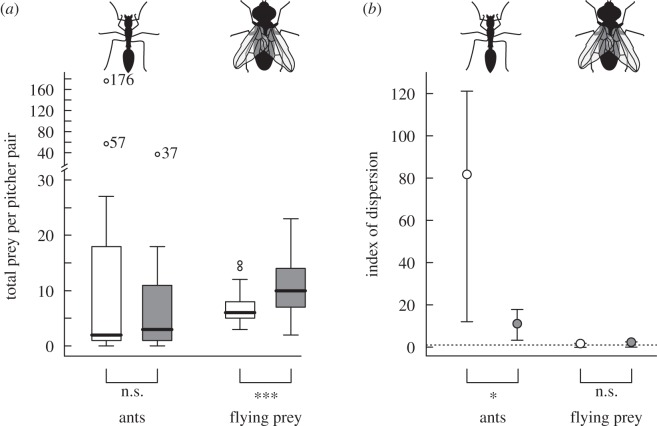
(a) Prey capture by natural (control, white boxes) and constantly active (wetted, grey boxes) pitchers within each plant. Bars denote medians, boxes represent the inner quartiles and whiskers contain all values within 1.5 times interquartile range. In the wetted case, more than 2/3 of all ants were captured by two individual pitcher pairs, rendering the 2.5-fold difference in across-pitcher ant prey sum non-significant on the individual pitcher level. Wetted pitchers captured on average significantly more flying prey. (b) Index of dispersion for prey captures by control (white circles) and wetted (grey circles) pitcher traps. The bars denote the 95% CI for each index value estimated from bootstrap randomisations. Ant captures were significantly more clumped in the control than in wetted pitchers.